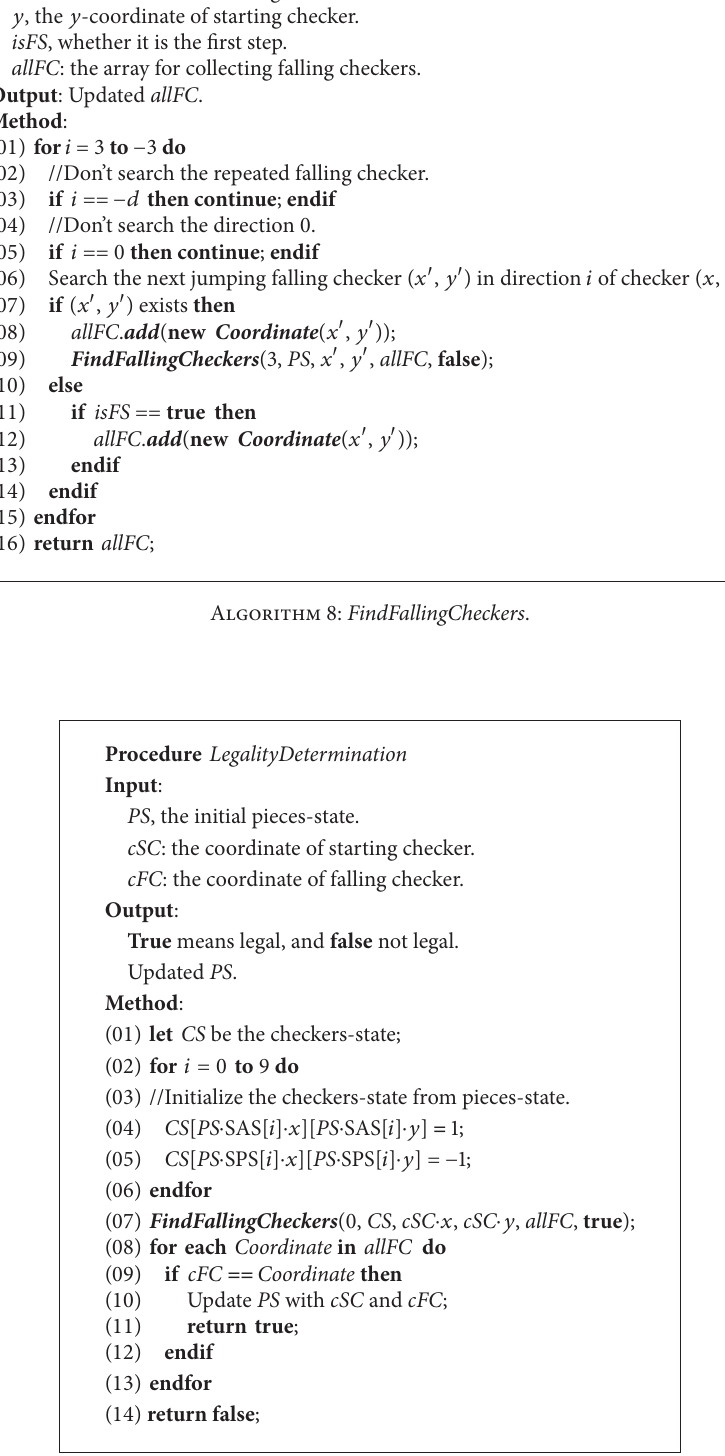
Algorithm 9: LegalityDetermination